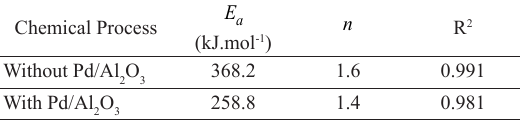
decomposition 4 O material. 2 3